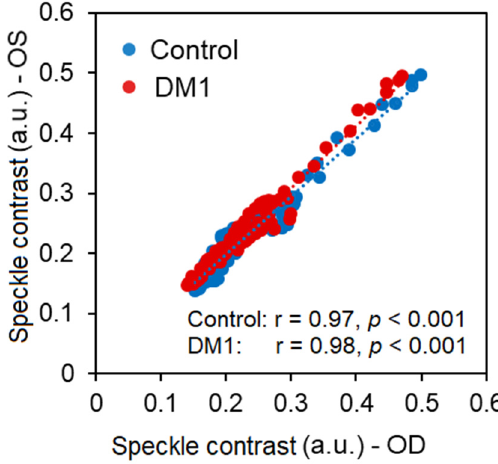
Figure 3. Correlation in speckle contrast between right (OD) and left eyes (OS) for control group (in blue) and DM1 group (in red). Represented data points include inner retinal layer (IRL), outer retinal layer (ORL), and choroid.